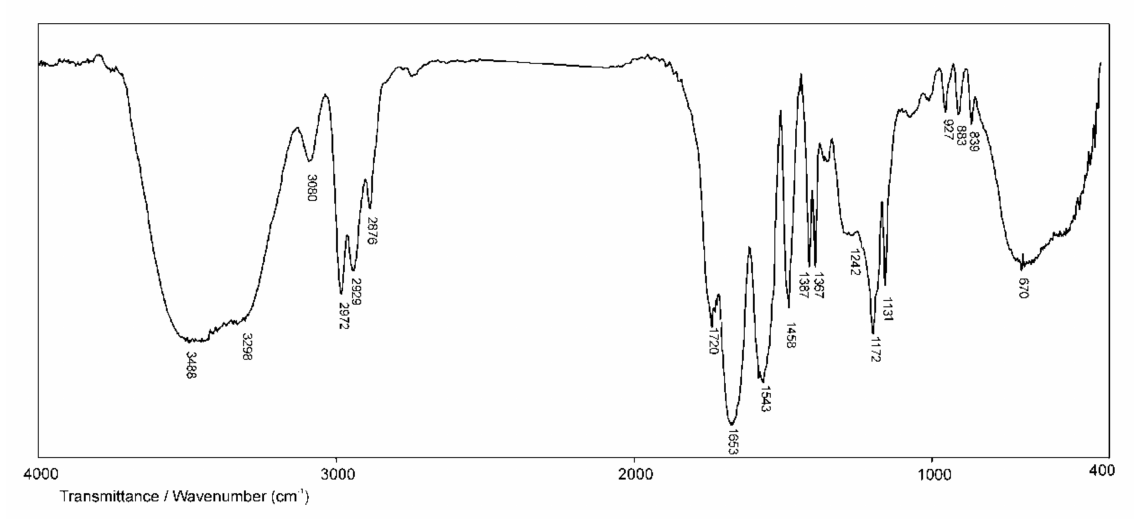
Figure 7. FTIR spectrum of the synthesized copolymer p(NIPAM-co-AA). In the FTIR spectrum of the synthesized p(NIPAM-co-AA) copolymer (Figure 7), the absence and shifts of certain characteristic absorption bands of NIPAM and AA can be ob- served. The absence of the absorption bands originating from the valence vibrations of vinyl C=C bonds, ν (C=C), of the monomers and cross-linker in the range of 1640–1620 cm − 1 , and in-plane deformation vibrations, δ (=C–H), in the range of 1450–1200 cm − 1 indicates the successful polymerization. Also, the absence of the bands originating from out-of-plane C–H bending vibrations, γ (=C–H), which occur in the NIPAM and AA spectra at 989 and 918 cm − 1 , and 1044 and 982 cm − 1 respectively, clearly indicates that vinyl groups of monomers participated in the polymerization process. The carboxyl and alkylated